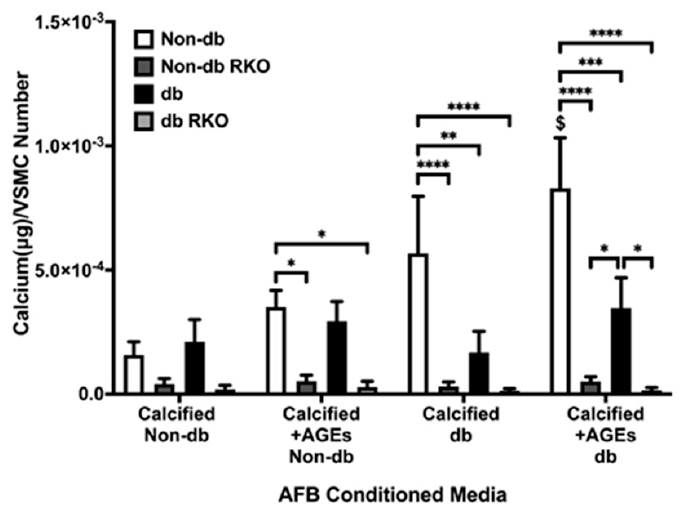
Figure 1. VSMCs responded to diabetic and non-diabetic AFB conditioned media. Primary VSMCs were isolated and treated with AFBs-conditioned media at a dilution of 1:10 in 2% FBS genotype appropriate DMEM for 7 days. Calcium ( µ g) was normalized to the number of cells (DAPI) and graphs as mean ± SEM with n = 3–6 of independent replicates. Statistical analysis consisted of a two-way ANOVA and a Fisher’s LSD test post hoc ($ means p < 0.05 when compared to non-db CM in the same genotype of treated cells, * p < 0.05, ** p < 0.01, *** p < 0.001, **** p <